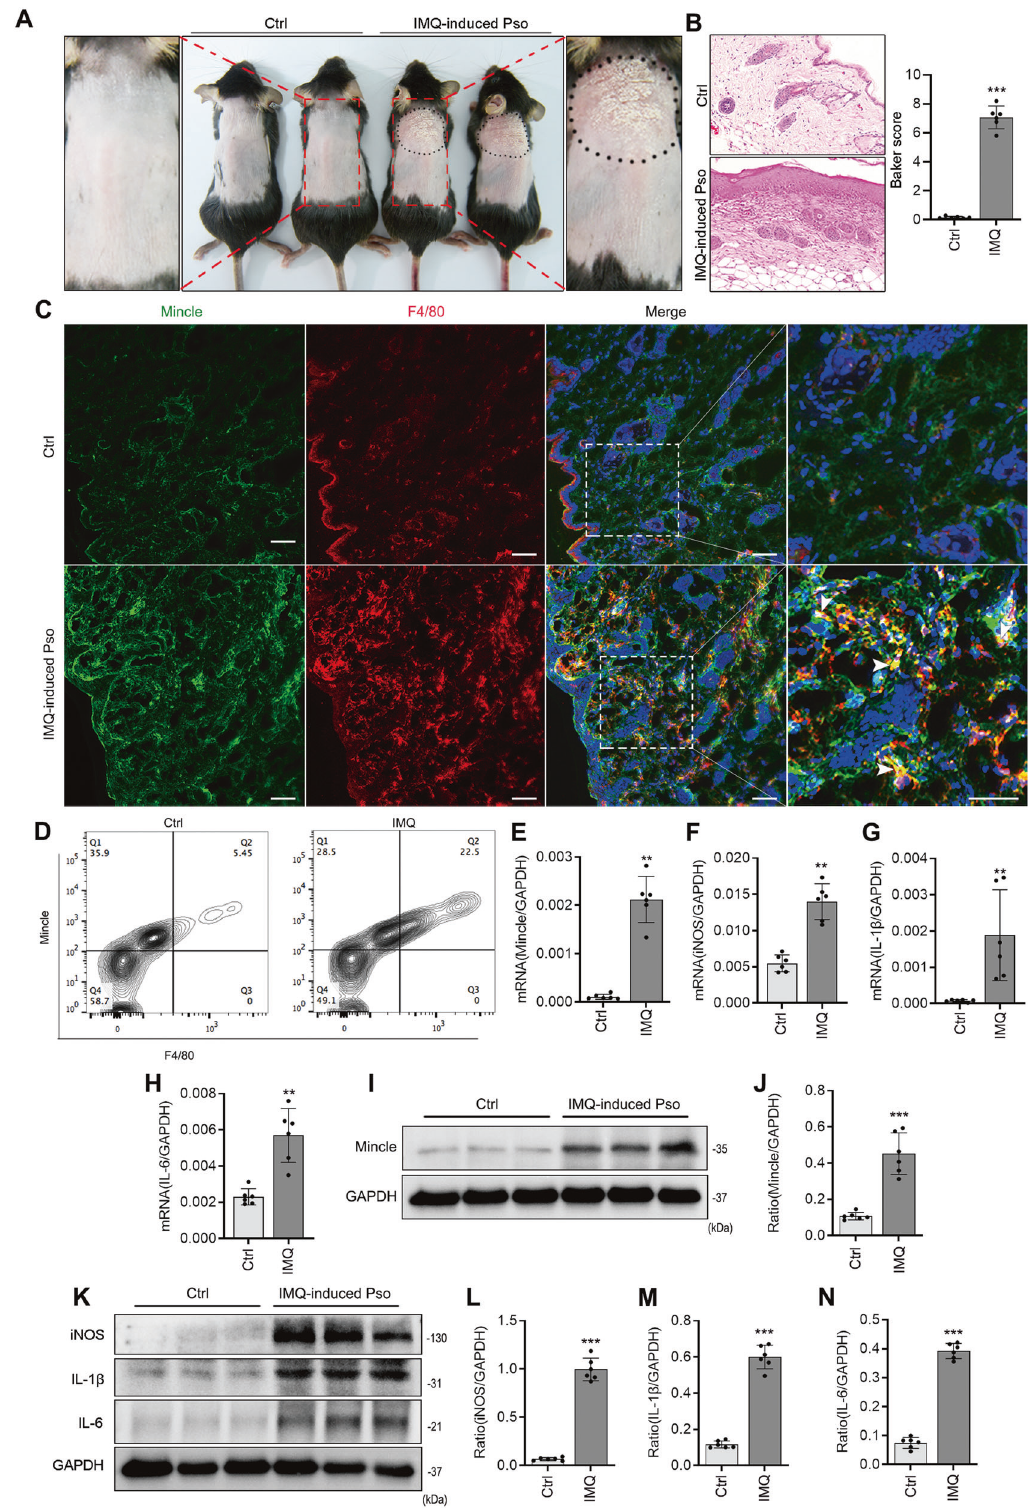
Fig. 2 Mincle is upregulated with severe skin in fl ammation in IMQ-induced psoriasis mouse model. A Psoriasis-like skin lesions induced by miquimod. B Representative images of H&E staining and baker score showing the skin tissue pathology of Ctrl and IMQ mouse. C Representative images of immuno fl uorescence staining and quanti fi cation showing a markedly increased level of Mincle and F4/80 in the skin of psoriasis mouse. D Flow cytometry detected the expression of Mincle and F4/80 in cell suspension of skin. E – H Real-time PCR analyze the mRNA expression of Mincle, iNOS, IL-1 β and IL-6 mRNA. I , J Western blot results showed that Mincle was increased in the skin lesions of psoriasis mice caused by IMQ. K – N Western blot detected the protein levels of iNOS, IL-1 β and IL-6. n = 6 in each group. ** P < 0.01, *** P < 0.001 vs.